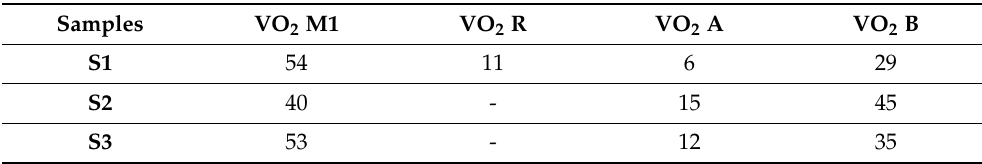
Table 2. Percentage of the dominant VO 2 phases detected in the thin films grown on LSAT and Si